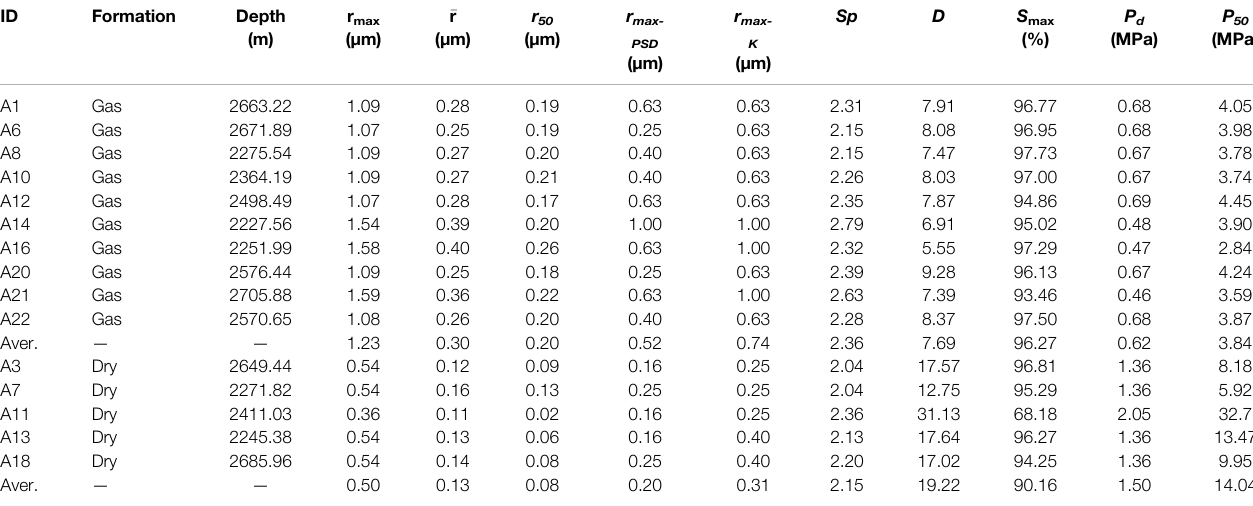
TABLE 2 | Parameters obtained from HPMI experiment.